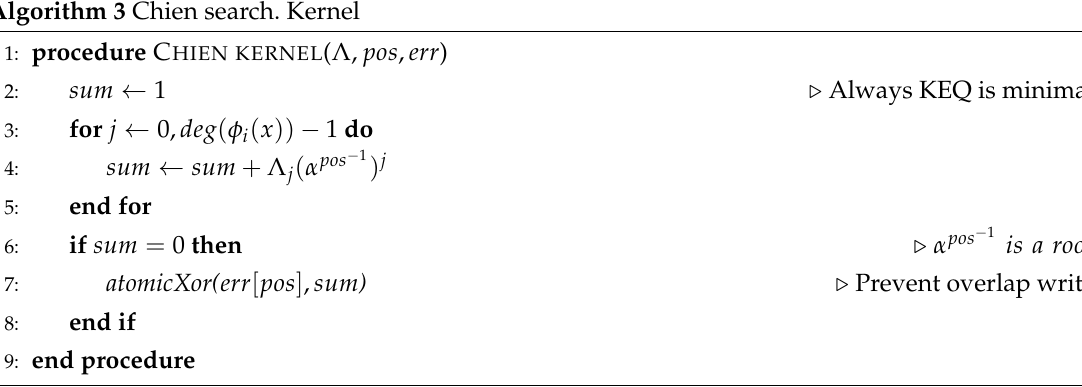
Algorithm 3 Chien search.